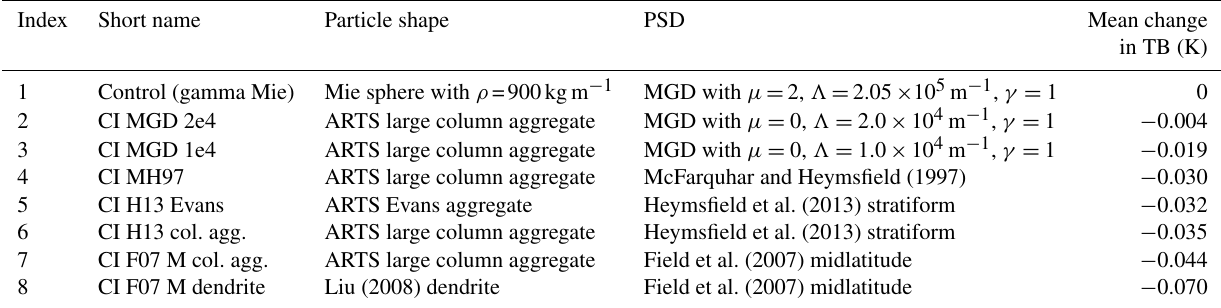
Figure 3. Global mean change in simulated brightness temperature when using different options for the shape of convective snow, compared to the control in which the Liu sector snowflake is used for all snow. Table 3. Possible microphysical changes for cloud